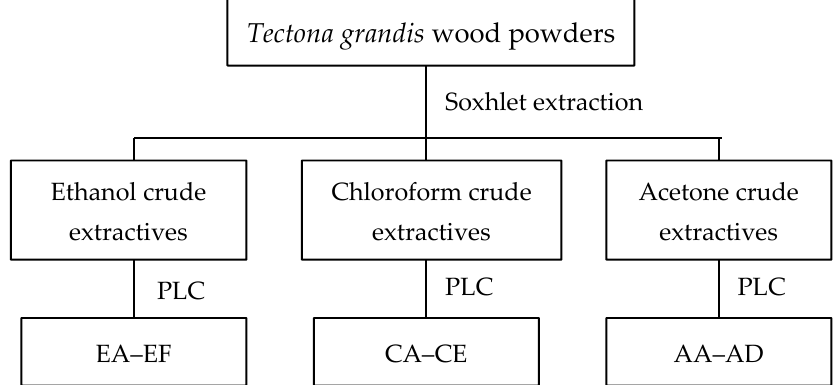
Figure 1. Schematic representation of the extraction and fractionation performed for T. grandis wood